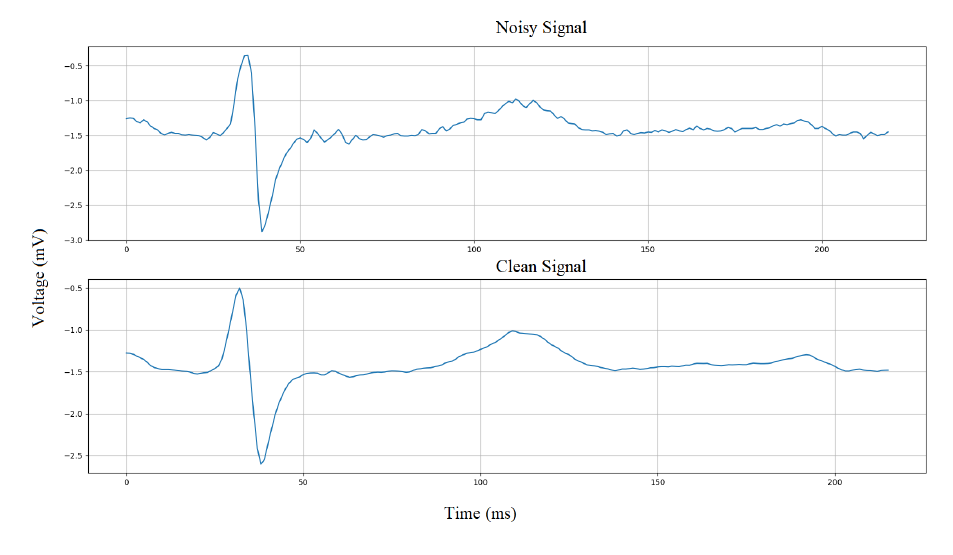
Figure 5. Average filter